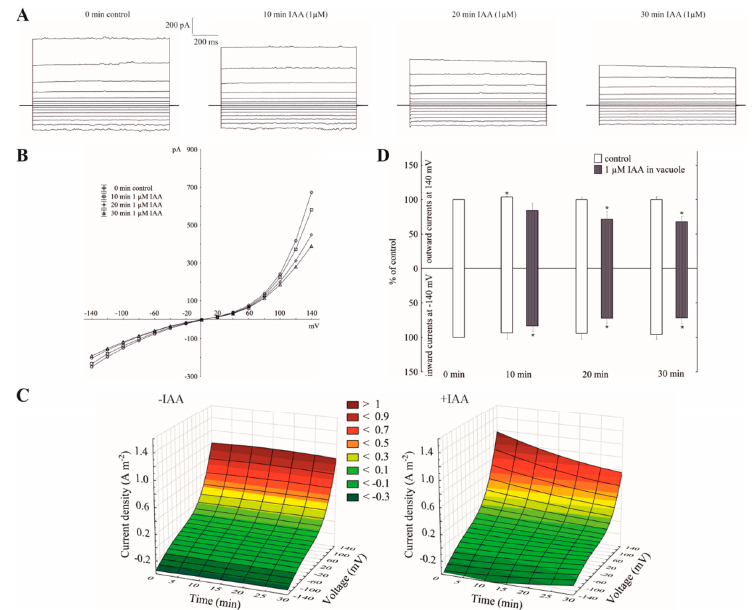
Figure 3. Effect of vacuolar auxin (1 µM IAA) on the fast-activating currents. ( A ), An example of a whole-vacuole FV current recording in symmetrical 100 mM KCl and in the presence of vacuolar IAA (auxin was added to the pipette solution, luminal IAA). Control at “0 time” (0 min control) means the whole-vacuole FV current was recorded immediately after gaining the access to the whole vacuole in the control medium; however, the current in the absence and presence of IAA was recorded 5, 10, 15, 20, 25 and 30 min later. For clarity, only the FV currents in the control (0 min control) and presence of IAA after 10, 20 and 30 min were shown. ( B ), The instantaneous vacuolar currents shown as a function of voltage (the data are from the same experiment as shown in A). ( C ), The current–voltage relationships shown as a function of time. The whole-vacuole currents were recorded in symmetrical 100 mM KCl in the absence ( − IAA) and presence (+IAA) of vacuolar IAA. The data are the means of at least six independent experiments. ( D ), The whole-vacuole FV currents recorded at − 140 and +140 mV in the presence of 1 µM IAA in a vacuole. The data are expressed as a % of the control (0 min control). The means ± SE of at least six different vacuoles are shown. The normal distribution was evaluated by the Shapiro–Wilk test ( p > 0.05). The statistical differences between control at 0 min and other variants at the same voltage were analyzed a using paired t -test ( p < 0.05). Asterisk (*) indicates significant difference.